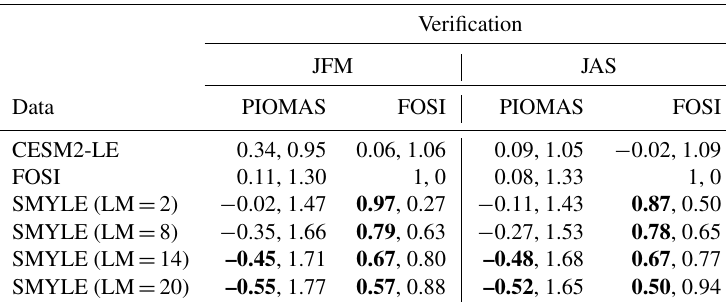
Table 2. Skill scores for detrended Northern Hemisphere seasonal sea ice volume (SIV) anomalies (relative to 1980–2015 climatology) for JFM and JAS seasons (see Fig. 13 for corresponding non-detrended time series). Leftmost column lists the simulations being evaluated, including SMYLE at lead months 2, 8, 14, and 20. The remaining columns show ACC (left number; in bold if p < 0.1) and nRMSE (right number) evaluated against PIOMAS or FOSI. Time series were detrended prior to skill score